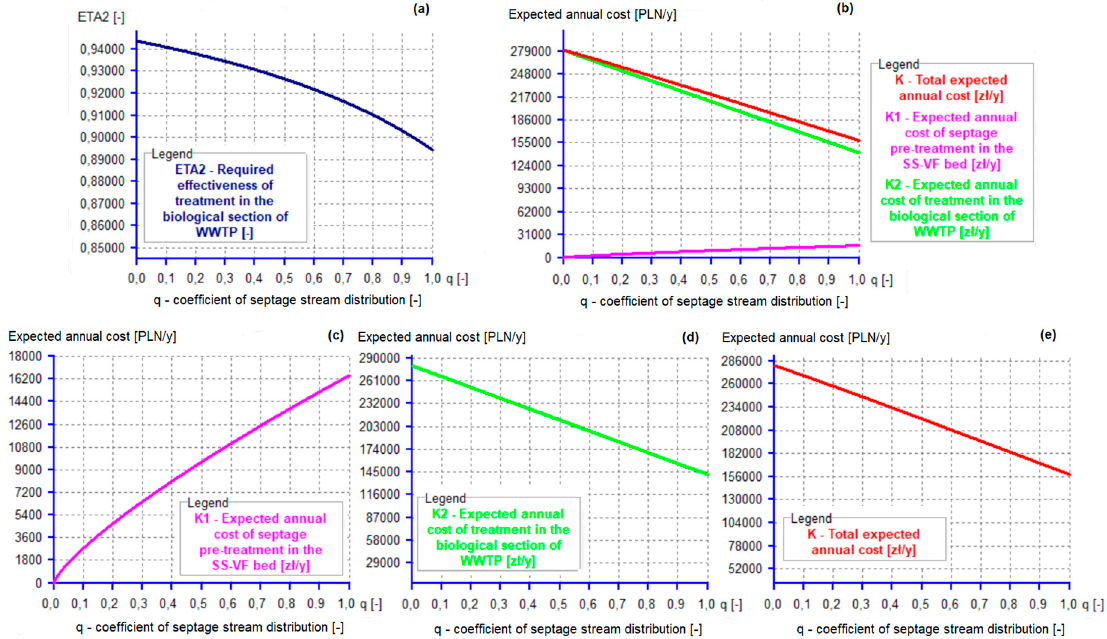
Figure 8. Example 2—summary of the dependence of decision variable on: required effectiveness of treatment in biological stage of WWTP ( a ) and costs K 1 , K 2 , K ( b ), cost K 1 ( c ), cost K 2 ( d ) and cost K ( e ).